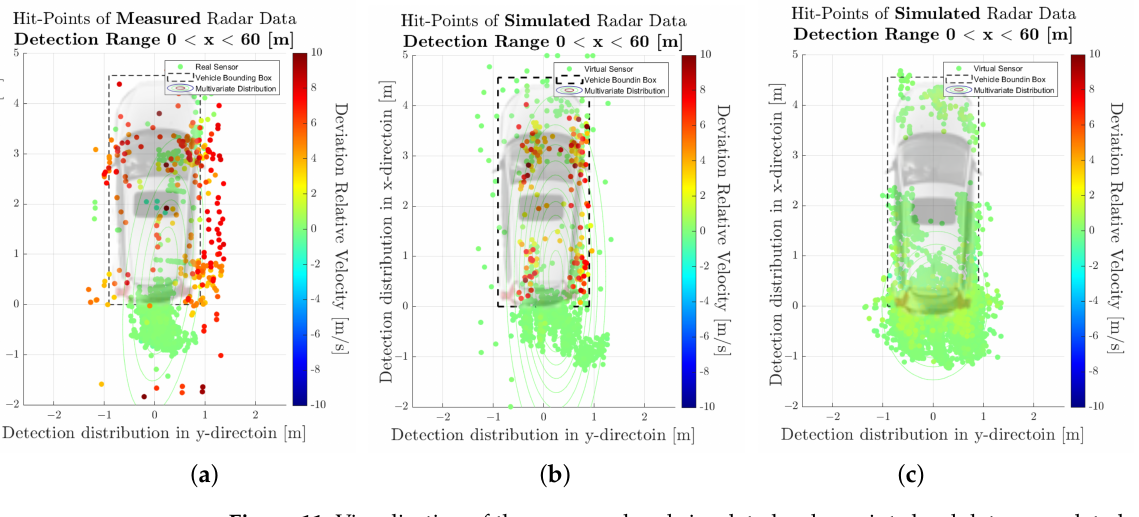
Figure 11. Visualisation of the measured and simulated radar point cloud data, cumulated over the entire measurement time, in the near-range detection sector. ( a ) Scatterplot of detections for the real sensor. ( b ) Scatterplot of detections for the sensor model presented in this paper. ( c ) Scatterplot of detections for the sensor model of commercial